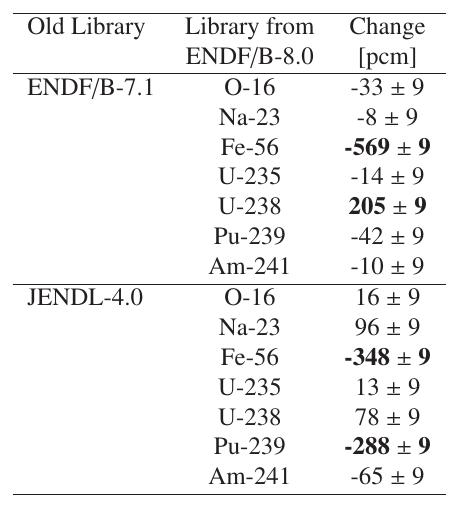
Table 4. Impact of the specific isotope library from ENDF / B-VIII.0 to k of oxide core at